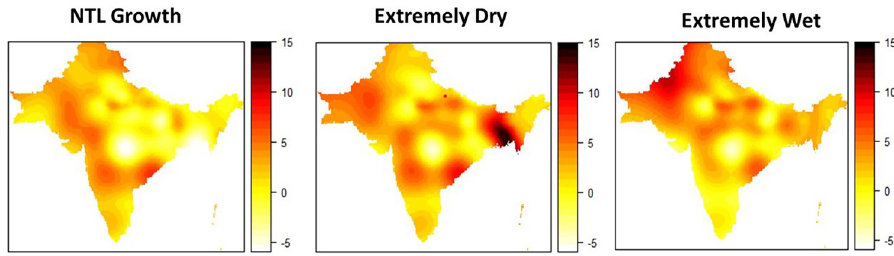
Fig 5. Predicted effect of local income shocks on child marriage rates of girls 15-17. Note : Difference in probability of child marriage when NTL growth, drought and flood indicators are changed by 2 standard deviation from district mean holding all else constant/ Based on test data (20%) of DHS India 15/16, Nepal 17, Bangladesh 14, Pakistan 17/18. Interpolation based on adaptive Kernel estimator following the methodology of Larmarange and colleagues [85]. Adaptive bandwidths set to number of persons